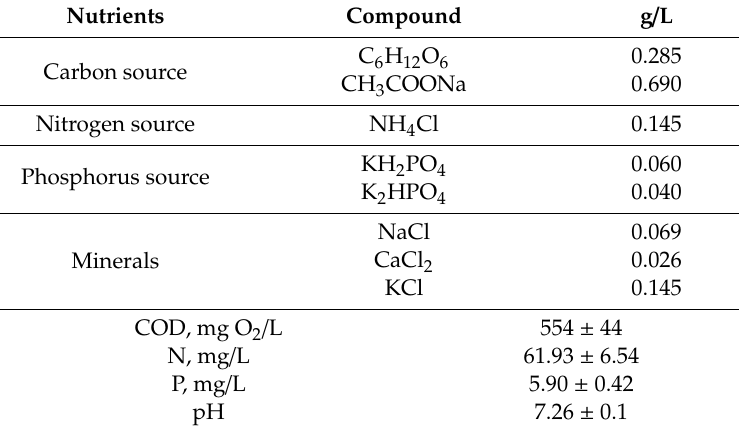
Table 1. Composition and characteristics of the synthetic wastewater.